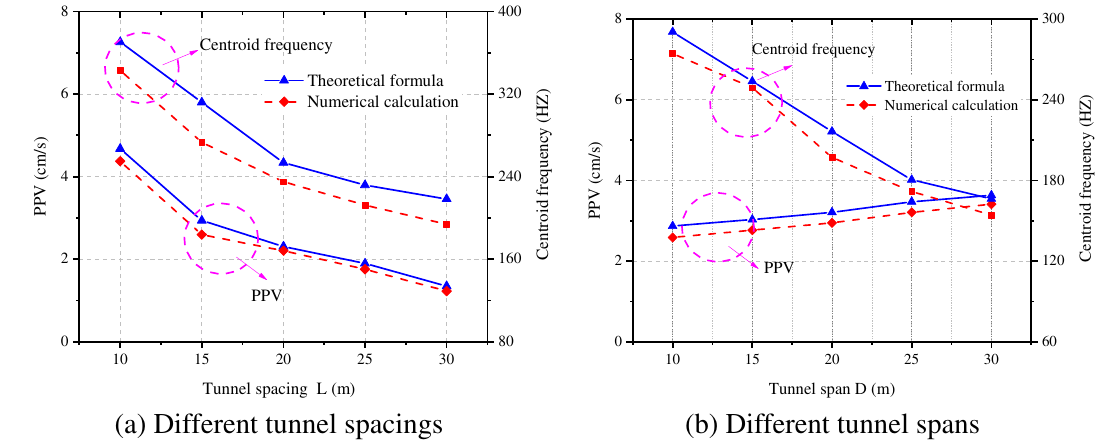
Figure 19. PPV and centroid frequency under different spacings and